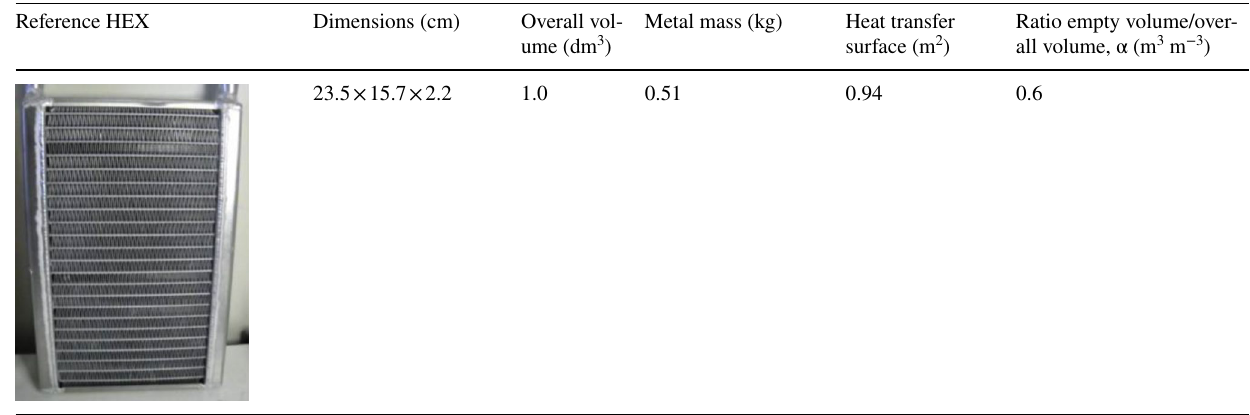
Table 2 Reference data for the aluminum finned-flat tube HEX Reference